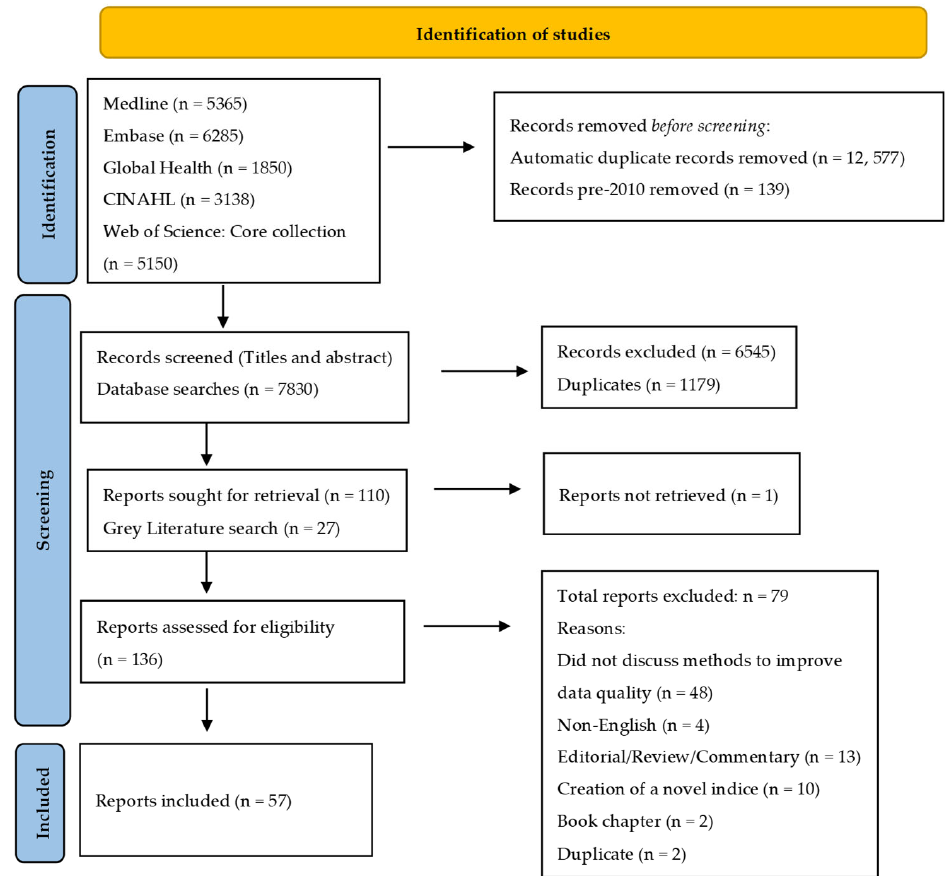
Figure 1. Flow diagram of included and excluded studies.